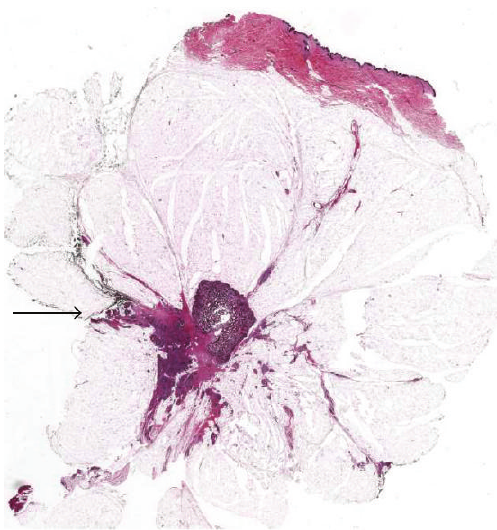
Figure 2: Quadrantectomy: the real inked margin can be easily recognized and distinguished from ink migration into fissures of the fat tissue